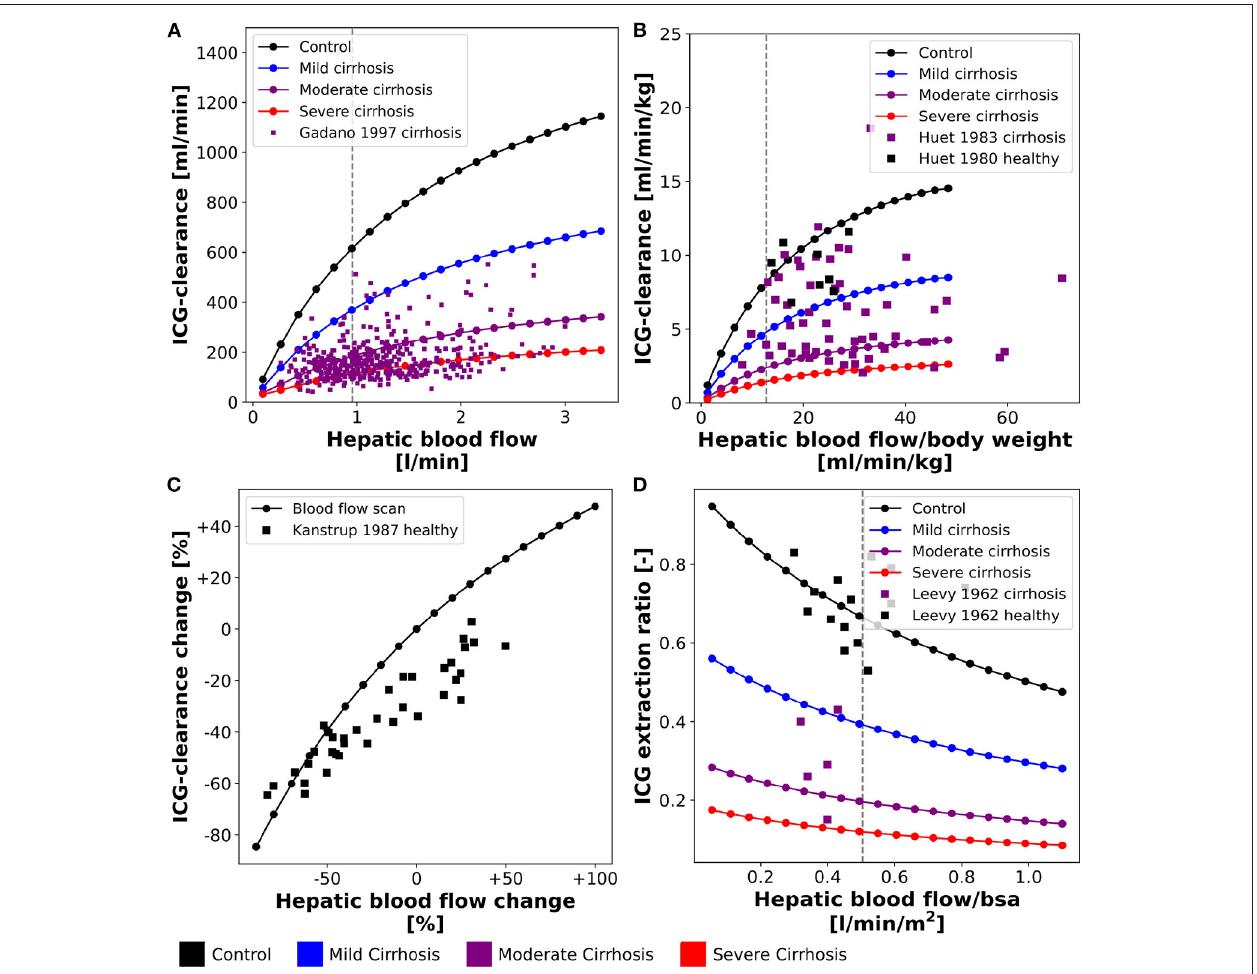
FIGURE 3 | Effect of hepatic blood flow on ICG parameters: For model validation multiple blood flow experiments were simulated and compared to clinical data sets. Simulations were performed for four different cirrhosis degrees (see section 2.1): Black: control, blue: mild cirrhosis: purple: moderate cirrhosis, red: severe cirrhosis. (A) Dependency of ICG-clearance on hepatic blood flow. Clinical data of subjects with liver cirrhosis from Gadano et al. (1997). (B) Dependency of ICG-clearance per kg body weight on hepatic blood flow per kg body weight. Clinical data of control and cirrhotic subjects from Huet and Lelorier (1980) and Huet and Villeneuve (1983). (C) Dependency of ICG-clearance on externally changed hepatic blood flow. Clinical data of healthy subjects from Kanstrup and Winkler (1987). (D) Dependency of ICG extraction ratio on hepatic blood flow. Clinical data of control and cirrhotic subjects from Leevy et al.